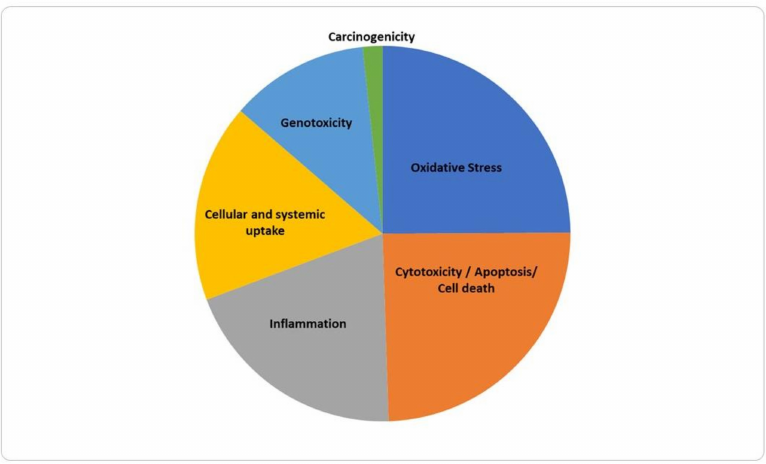
Figure 3. Endpoints identified in the literature that relate to TiO 2 -NPs